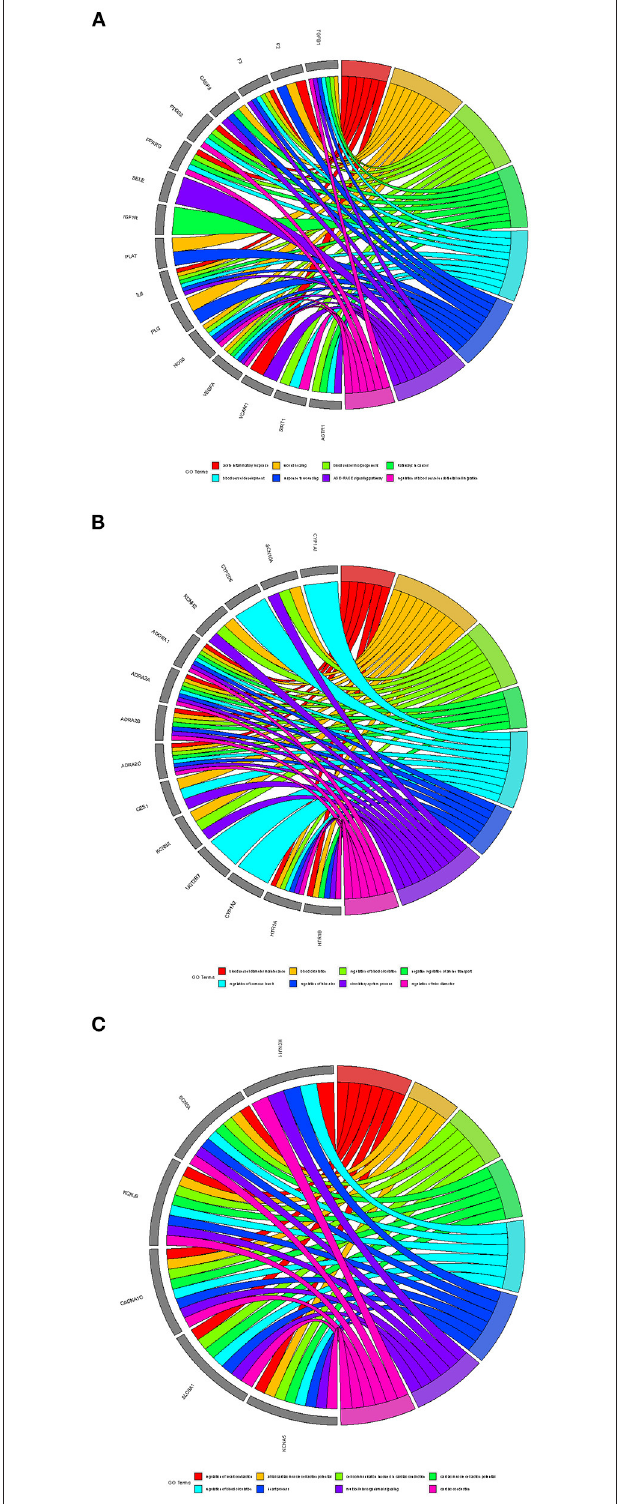
FIGURE 6 | The functional analysis of protein complexes. (A) Complex A. (B) Complex B. (C) Complex